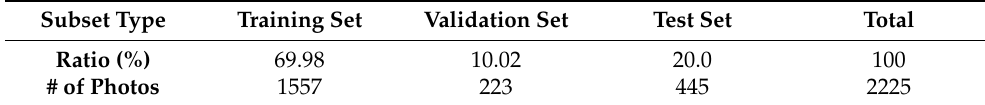
Table 4. Distribution of Data Collection.